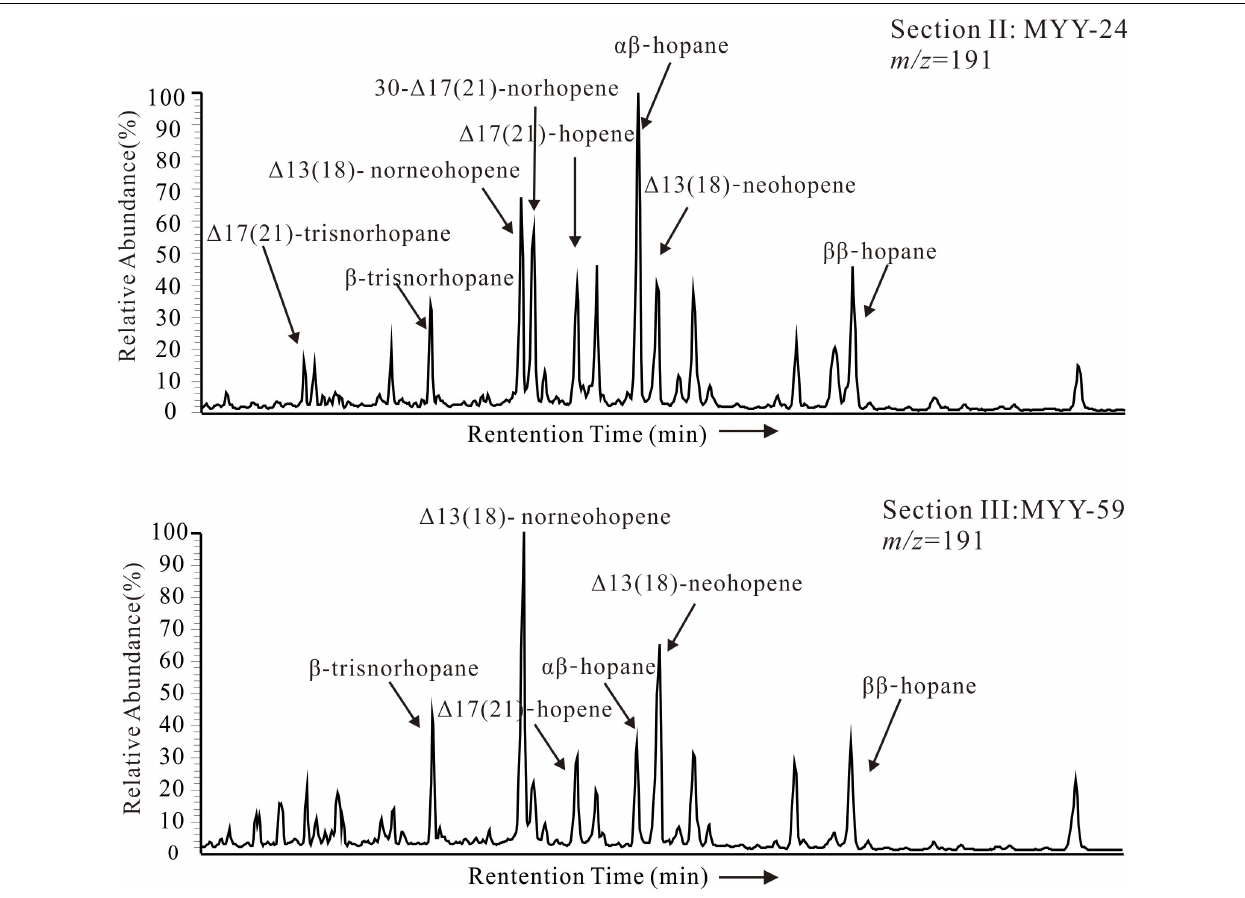
FIGURE 5 | The identification and distribution of hopanes in representative oil shale